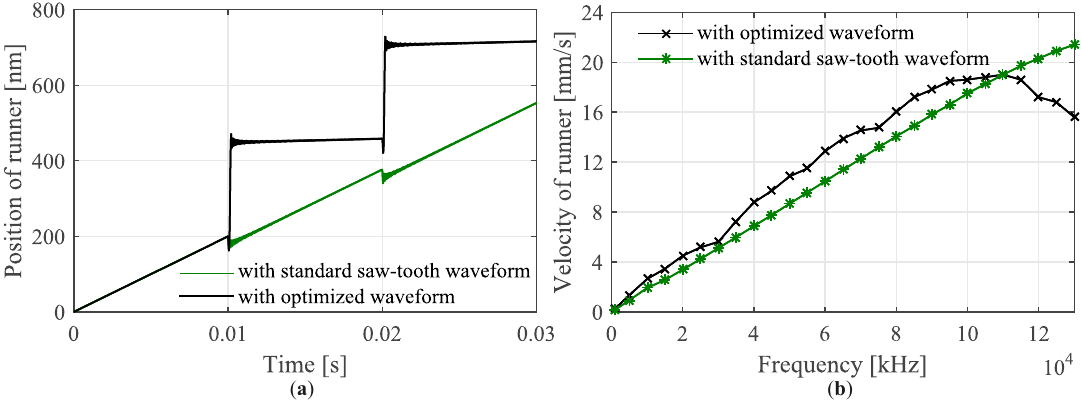
Figure 9. Comparison of simulation results with standard saw-tooth waveform and optimized waveform: ( a ) step size at driving frequency f = 100 Hz; ( b ) dependency of the average velocity of the runner on driving